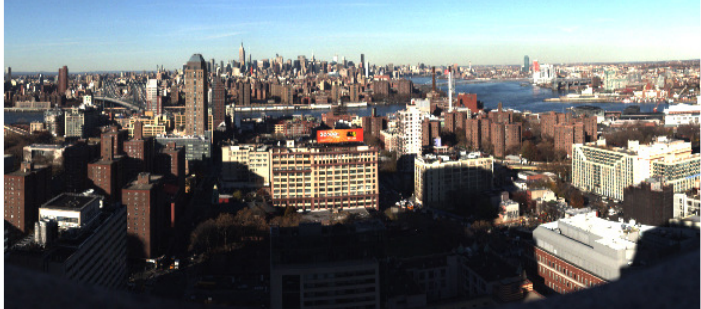
Figure 1. A false color image of a daytime scan of the NYC skyline with our hyperspectral instrument. For this image, RGB was mapped to ( 610 nm,540 nm,475 nm ) . The near scene is northern Brooklyn; the mid-scene is the Manhattan Bridge and the East River; while the far scene is Midtown Manhattan.